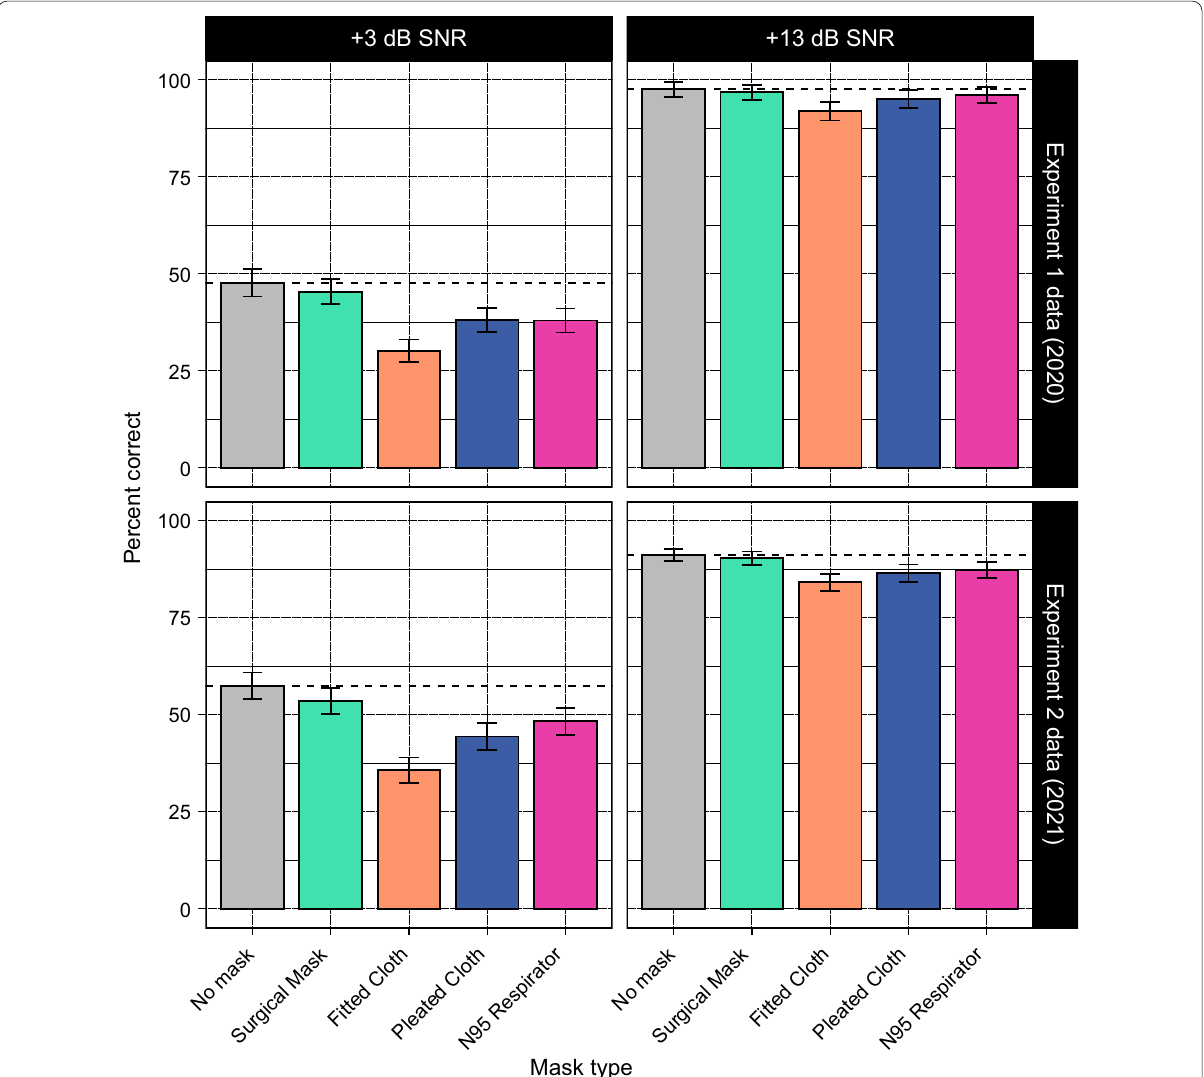
Fig. 2 Average performance by mask type and SNR, for each year of data collection. Overall, trends are similar between the two datasets, with participants from the 2021 experiment performing better in the low SNR condition than participants from 2020. Dashed lines indicate the average performance for the no-mask condition in each panel. Error bars indicate 95% confidence